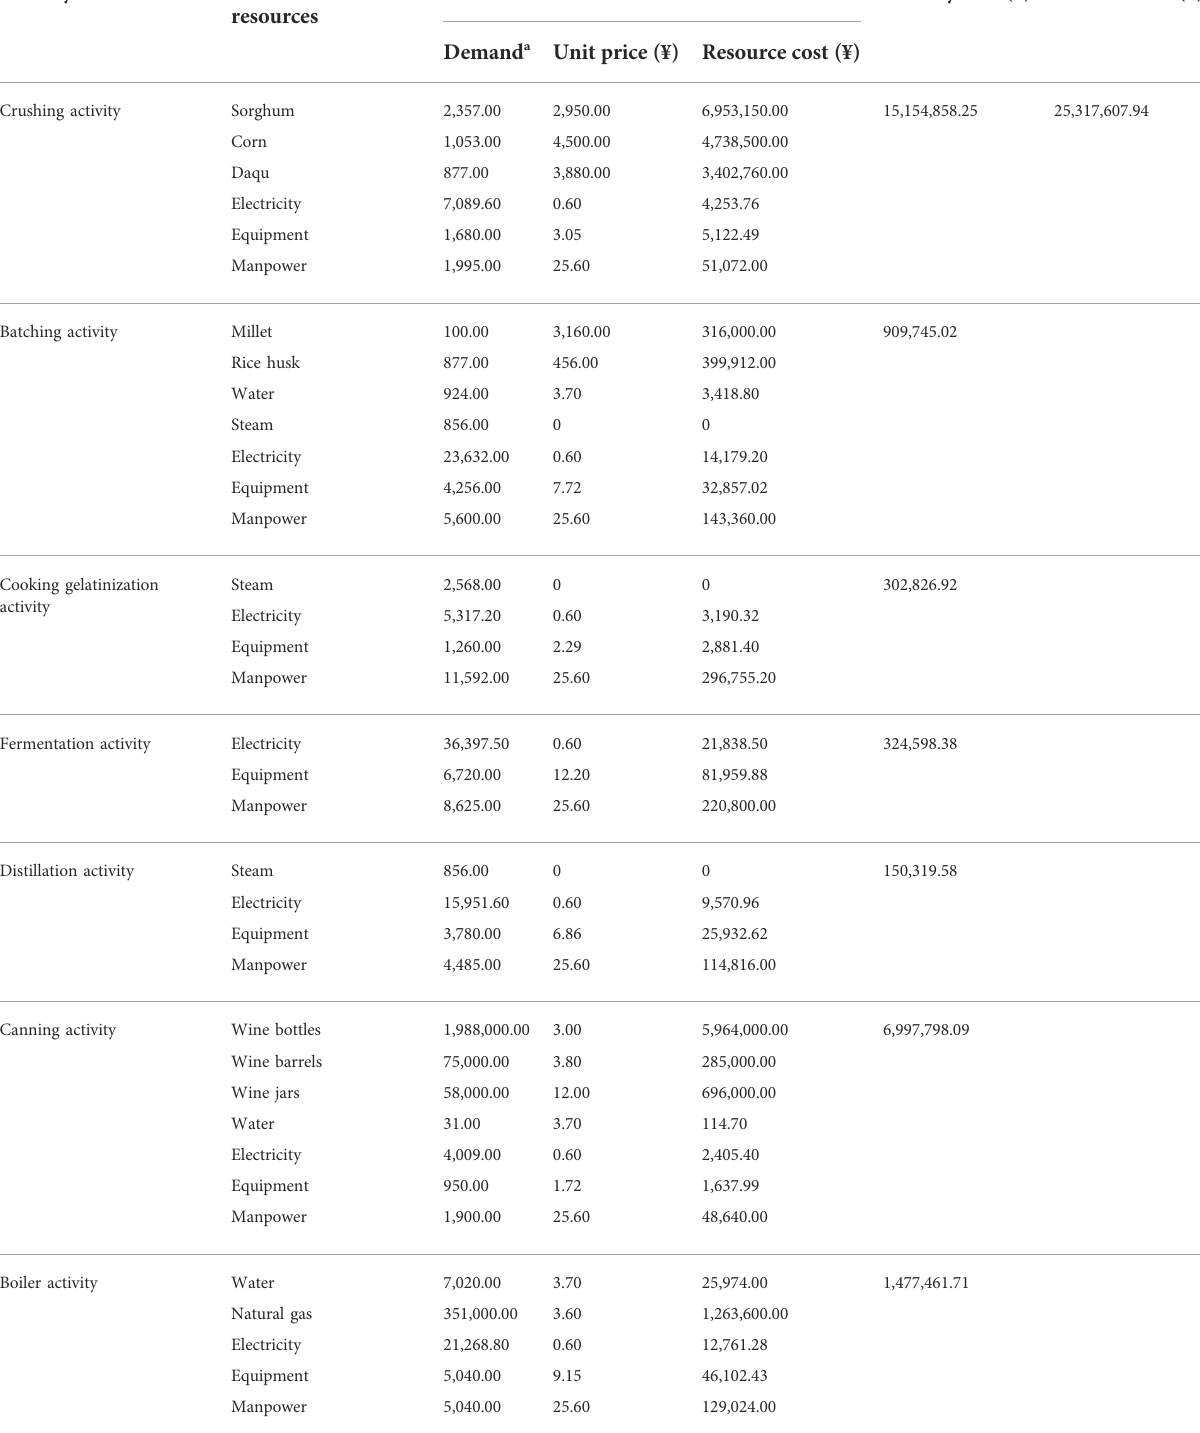
TABLE 4 Financial budget for production